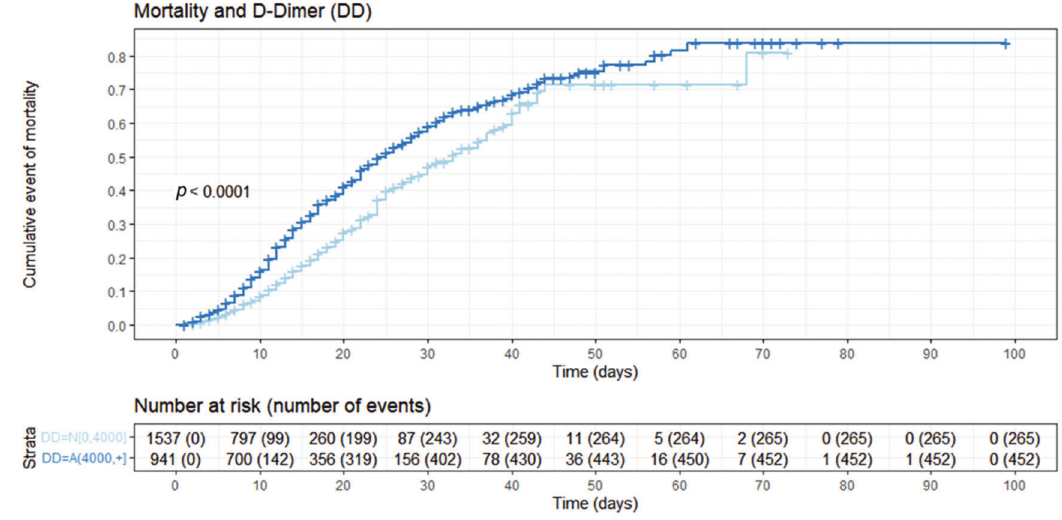
Figure 3 - Nelson–Aalen cumulative mortality plot stratified by D-dimer levels. This figure describes the cumulative mortality stratified by the D-dimer cut-off (greater or lower than 4,000 ng/mL FEU), with higher cumulative mortality observed in patients with high